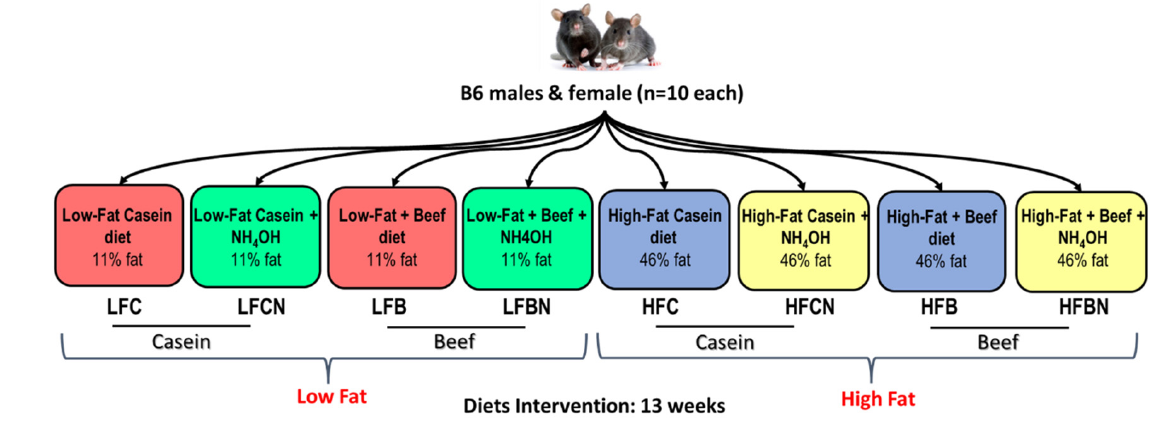
Figure 1. Study design and the classification of different groups. LFC = low fat casein; LFCN = low fat pH enhanced casein; LFB = low fat beef; LFBN = low fat pH enhanced beef; HFC = high fat ca- sein; HFCN = high fat pH enhanced casein; HFB = high fat beef; HFBN = high fat pH enhanced